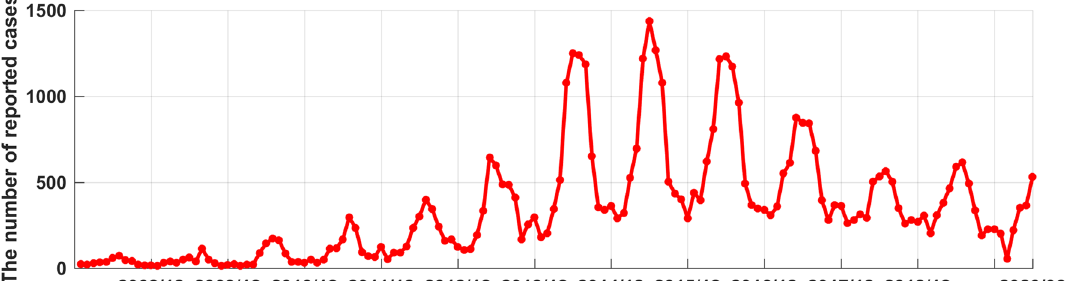
Figure 2. The time series of monthly reported cases of human brucellosis in Xinjiang from January 2008 to June